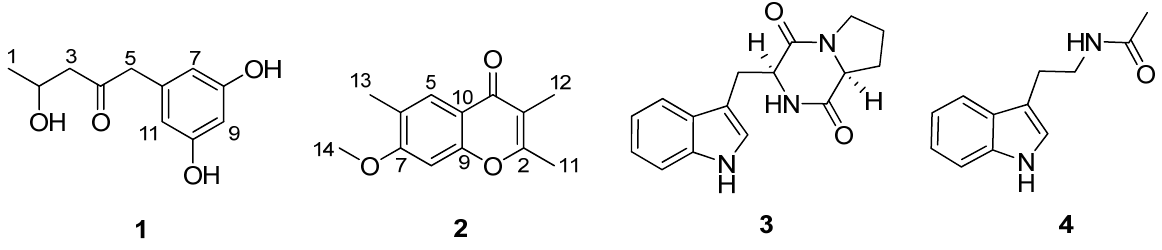
Figure 1. Chemical structures of compounds 1 – 4 .